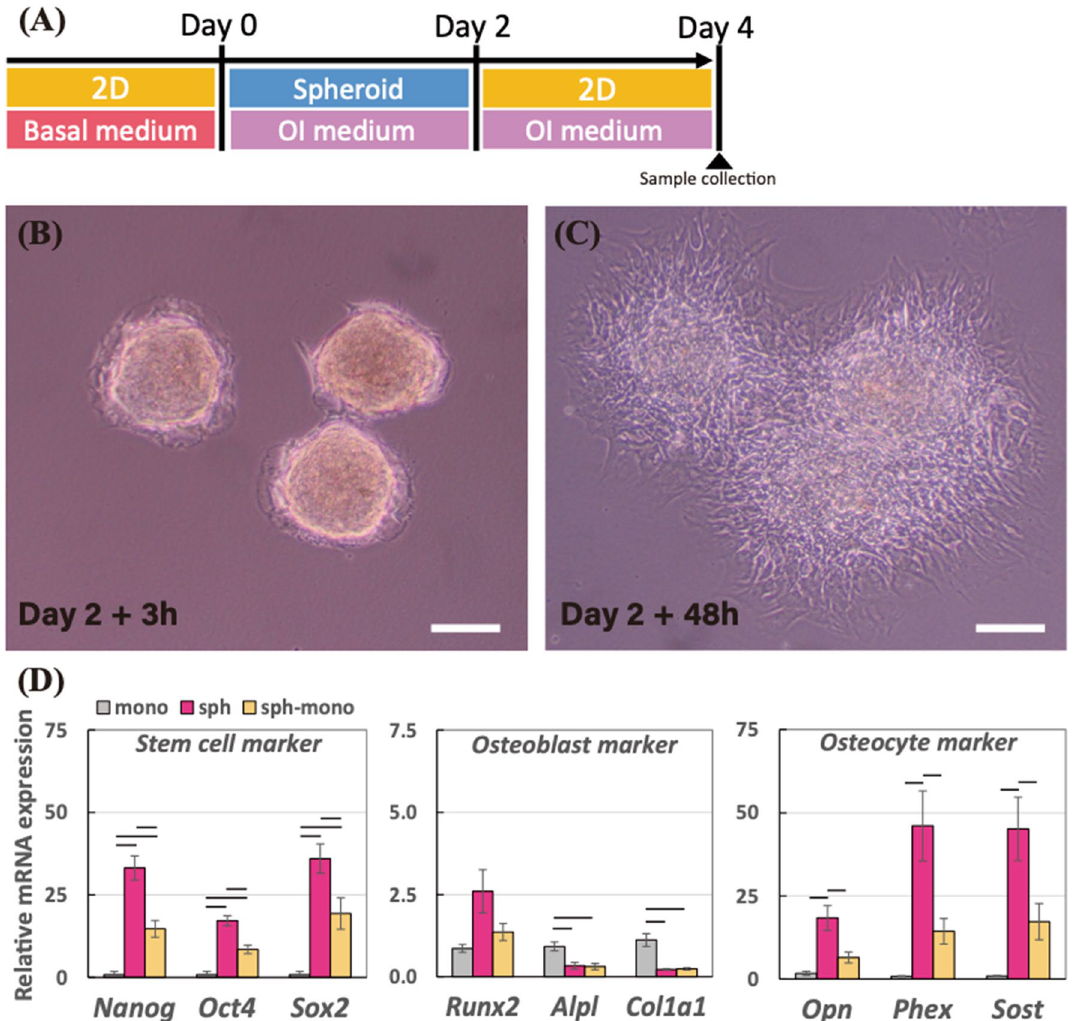
Figure 4. ( A ) Schematic of the experimental time line to prepare for cells dissociated from the spheroids (sph- mono) in the osteogenesis induction medium. Morphology of the spheroids transferred to the normal culture dish after ( B ) 3 h and ( C ) 48 h. The scale bar represents 200 μm. ( D ) Relative mRNA expressions of stem cell markers ( Nanog , Oct4 , and Sox2 ), osteoblast markers ( Runx2 , Alpl , and Col1a1 ), and osteocyte markers ( Opn , Phex , and Sost ) in monolayer and spheroid incubated for 4 days, and sph-mono were measured by real-time PCR. All the mRNA expressions were normalized to Gapdh expressions while the results were expressed as relative amounts against the expression of monolayer sample ( n = 6). The graphs represent the mean ± standard error. Bar indicates the significance between groups, which was calculated from ANOVA with Tukey’s HSD post- hoc test ( α =